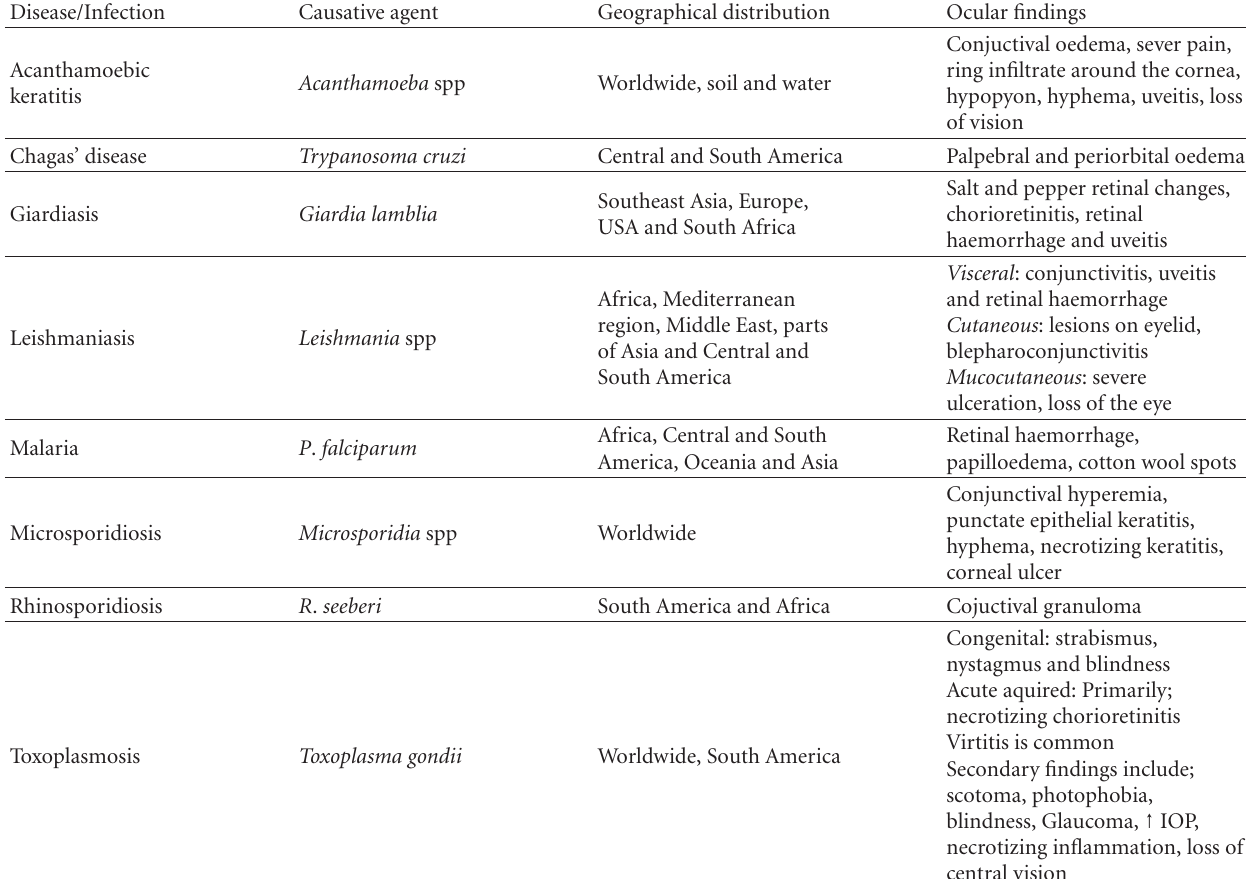
Table 1: Ocular parasitosis caused by protozoa ( geographical distribution & ocular findings